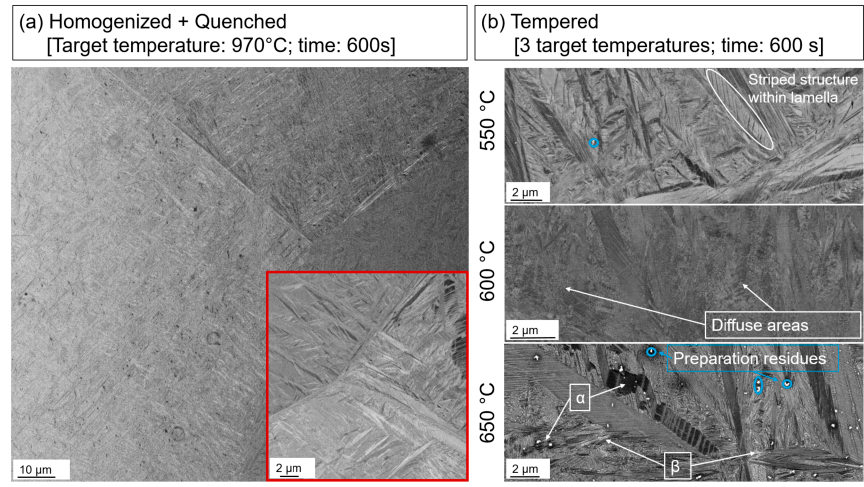
Figure 4. ( a ) SEM images (BSE mode) of the homogenized and quenched microstructure and ( b ) microstructure after tempering, imitating reheating to service temperatures.